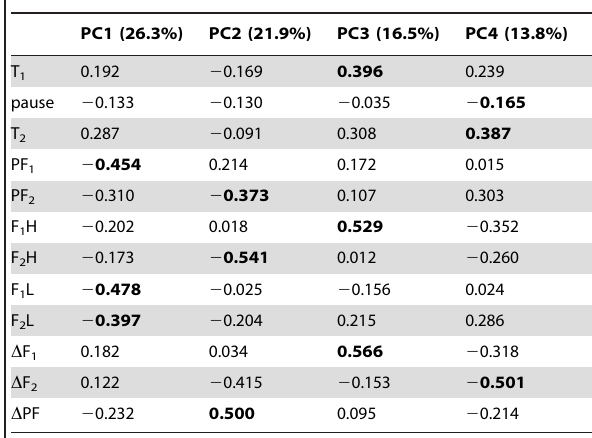
Table 2. Variable loadings of male cuckoo calls for four principal